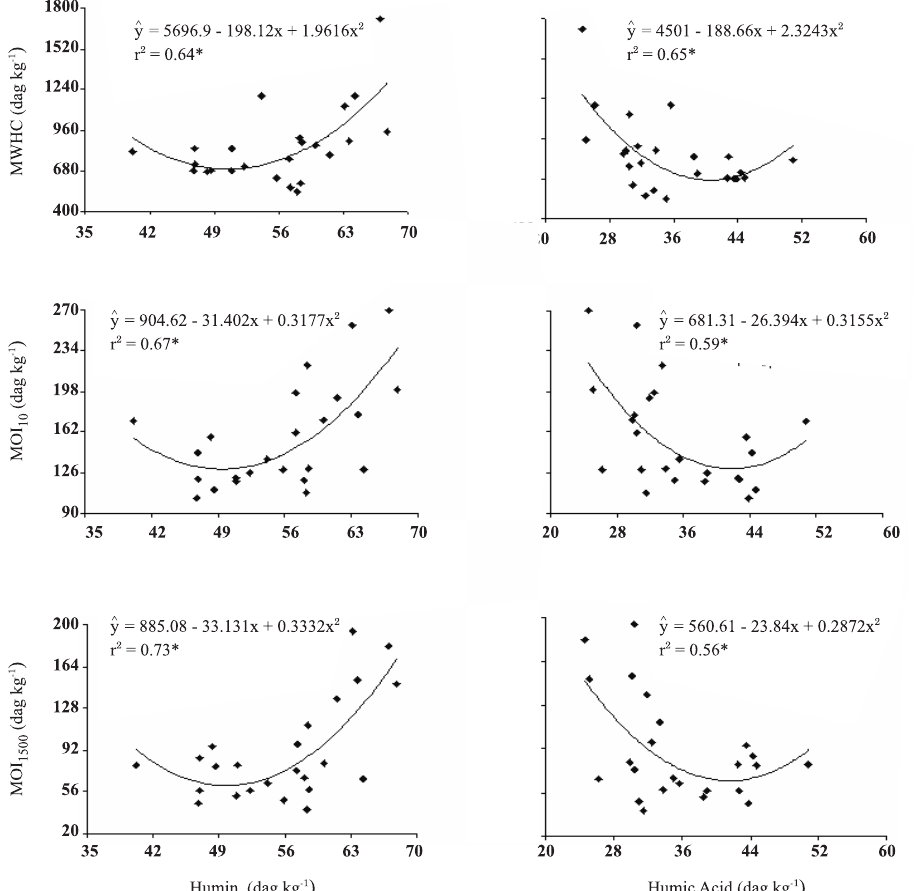
Figure 4. Maximum water holding capacity (MWHC), moisture at 10 kPa (Moi (Moi ), their relations with C-humin (H) and C-humic acids (HA) and the respective regression 1500 equations and correlation coefficients in the peatland conservation unit Pau-de-Fruta, Diamantina, MG. All regression equations were significant by the F test (p < 0.05 or p <